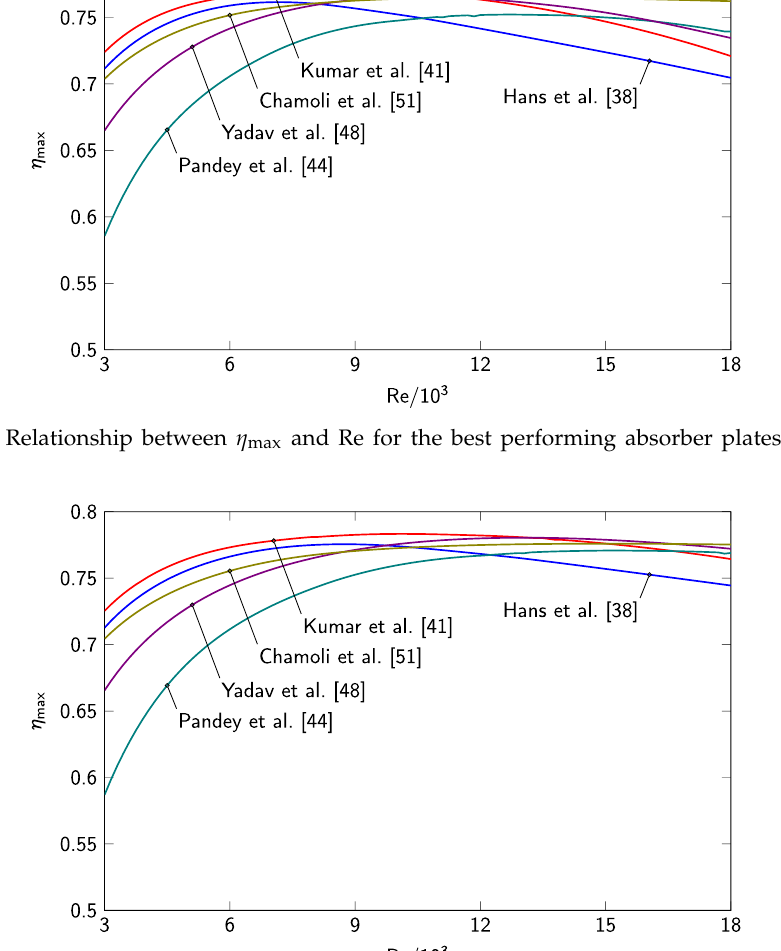
Figure 22. Relationship between η max and Re for the best performing absorber plates and ˙ G = 1000Wm − 2 .